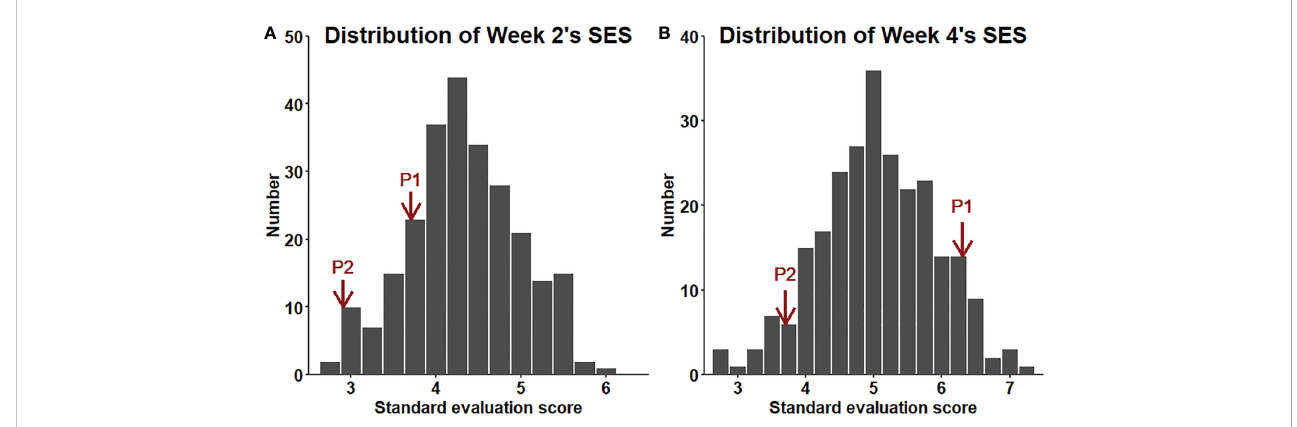
FIGURE 5 (A) : Distribution of the SES (BLUP) values of the RILs after two weeks of salt treatment. (B) : Distribution of the SES (BLUP) values of the RILs after four weeks of salt